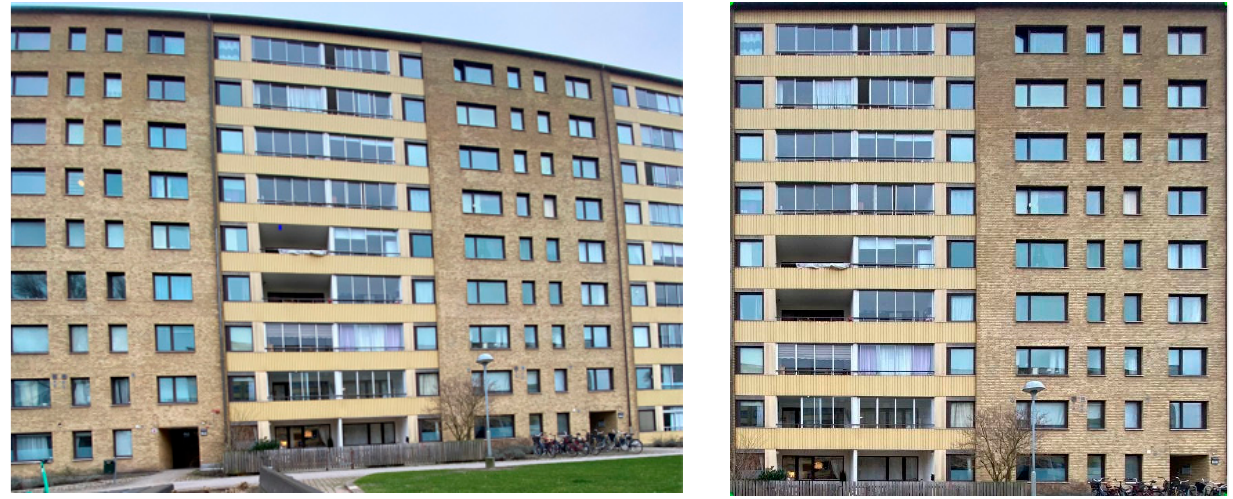
Figure 8. Façade images before and after barrel/pincushion and perspective distortion correction.